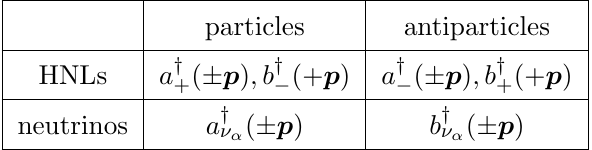
Table 3 . Creation operators for particles and